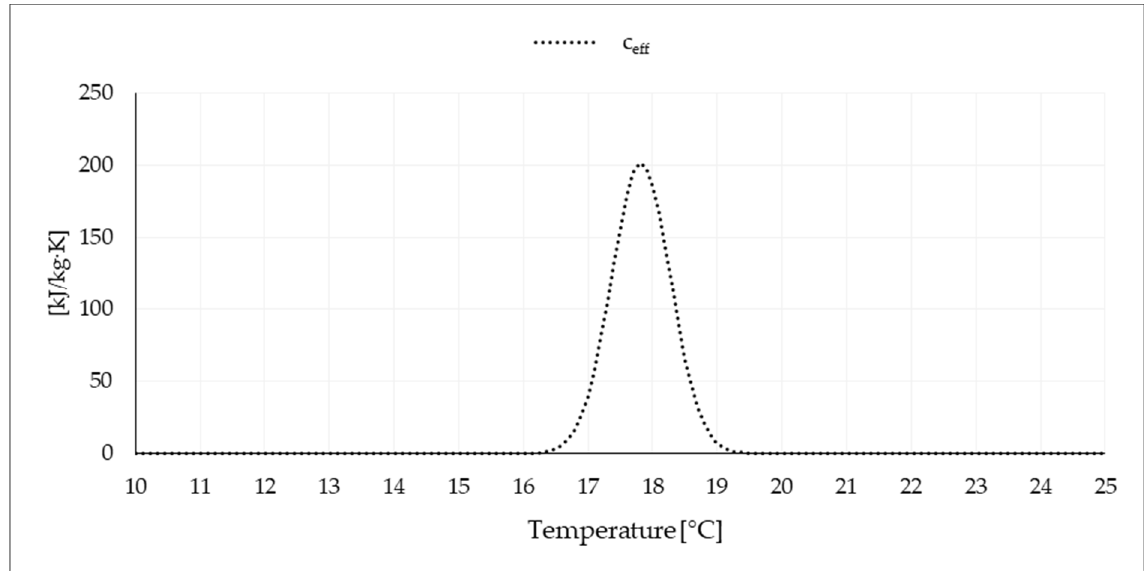
Figure 7. Effective heat capacity function used in numerical model.